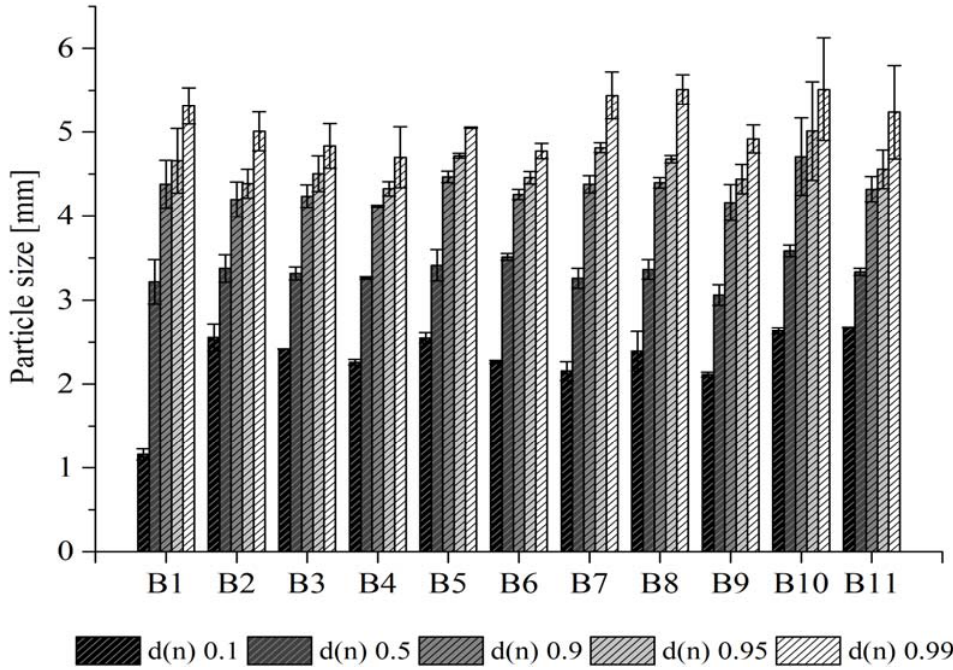
Figure 1. Numeric particle size distribution of paper granules from different batches based on the predetermined Feret’s diameter. A d(n) 0.5 represents the size where 50% of all granules are smaller or equal to the given number.